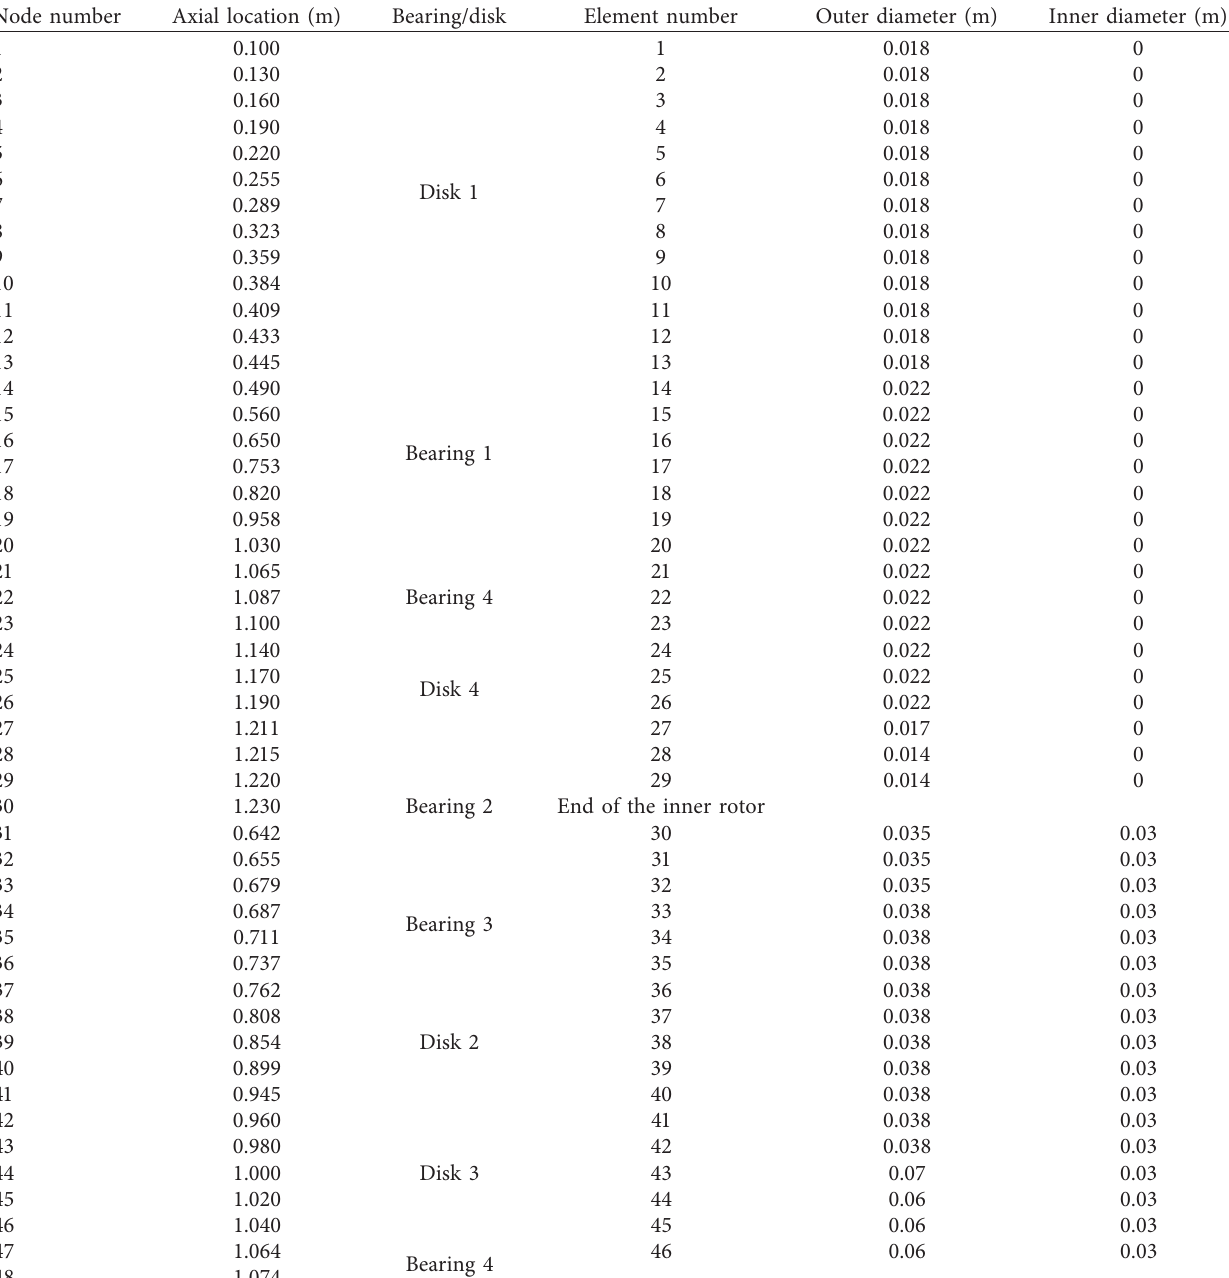
Table 9: Dimension and elements information of the dual rotor system.